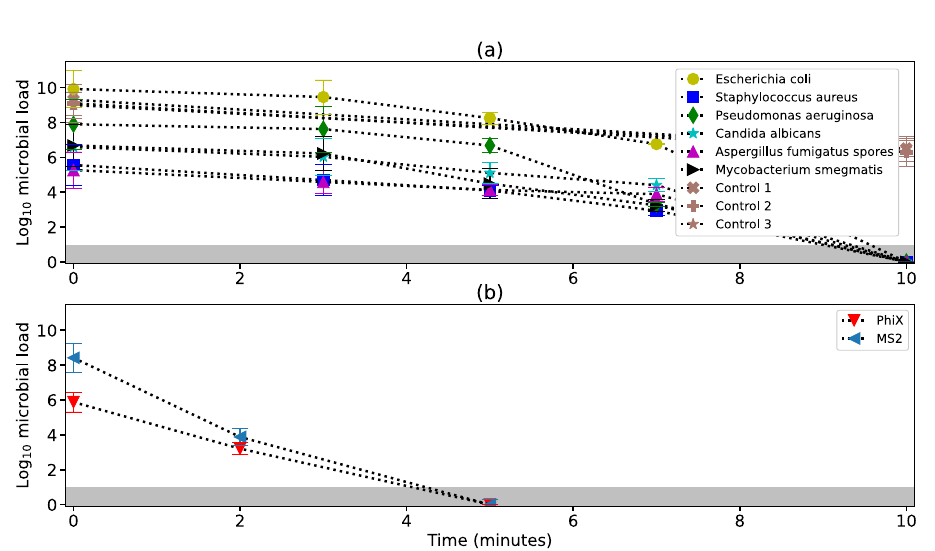
Figure 4. Reduction in microbial load inside test chamber. ( a ) Reduction in microbial load except viruses. The shaded region indicates limit of detection (LoD). Control 1, 2, 3 refer to control experiments employing respectively microbicidal surface without electric field, control surface with electric field and control surface without electric field. ( b ) Reduction in viral load. (created using Matplotlib module in python language 55